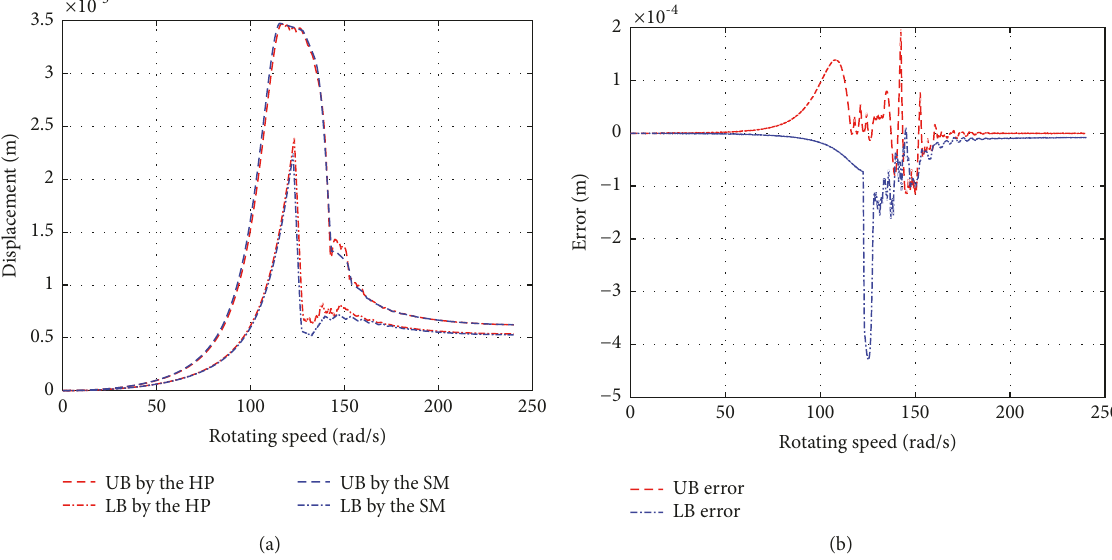
Figure 8: (a) Response ranges with multiple interval parameters calculated by the hybrid procedure and